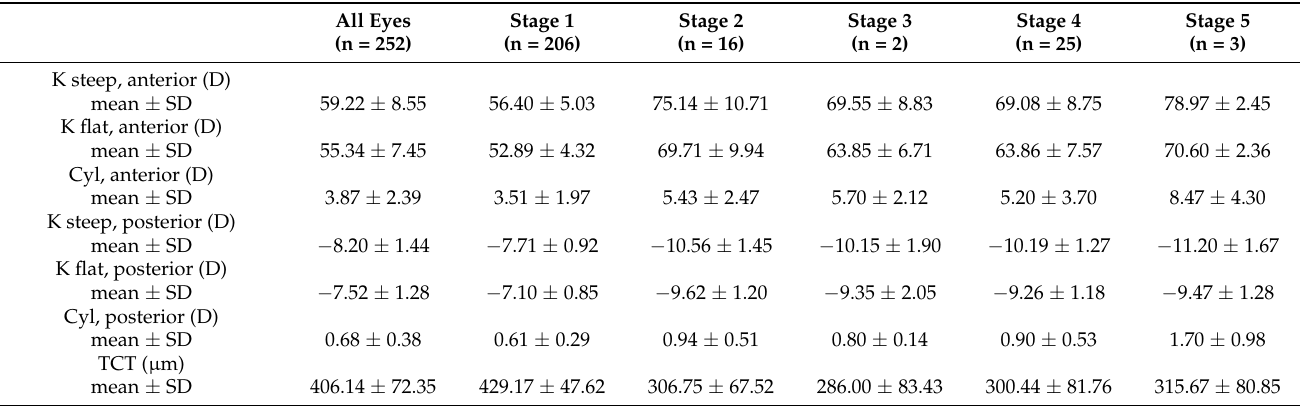
Table 3. Mean keratometry, cylinder and pachymetry values in the group classified with the Sandali